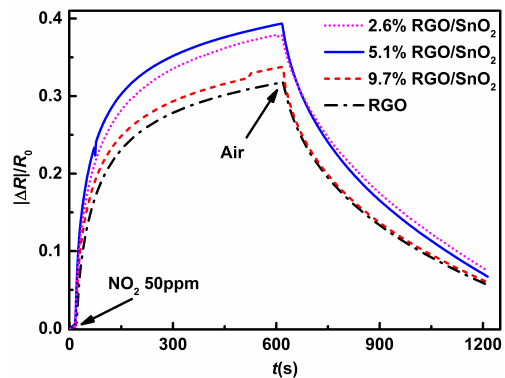
Figure 5. Responses of the sensors to 50 ppm NO 2 at room temperature.